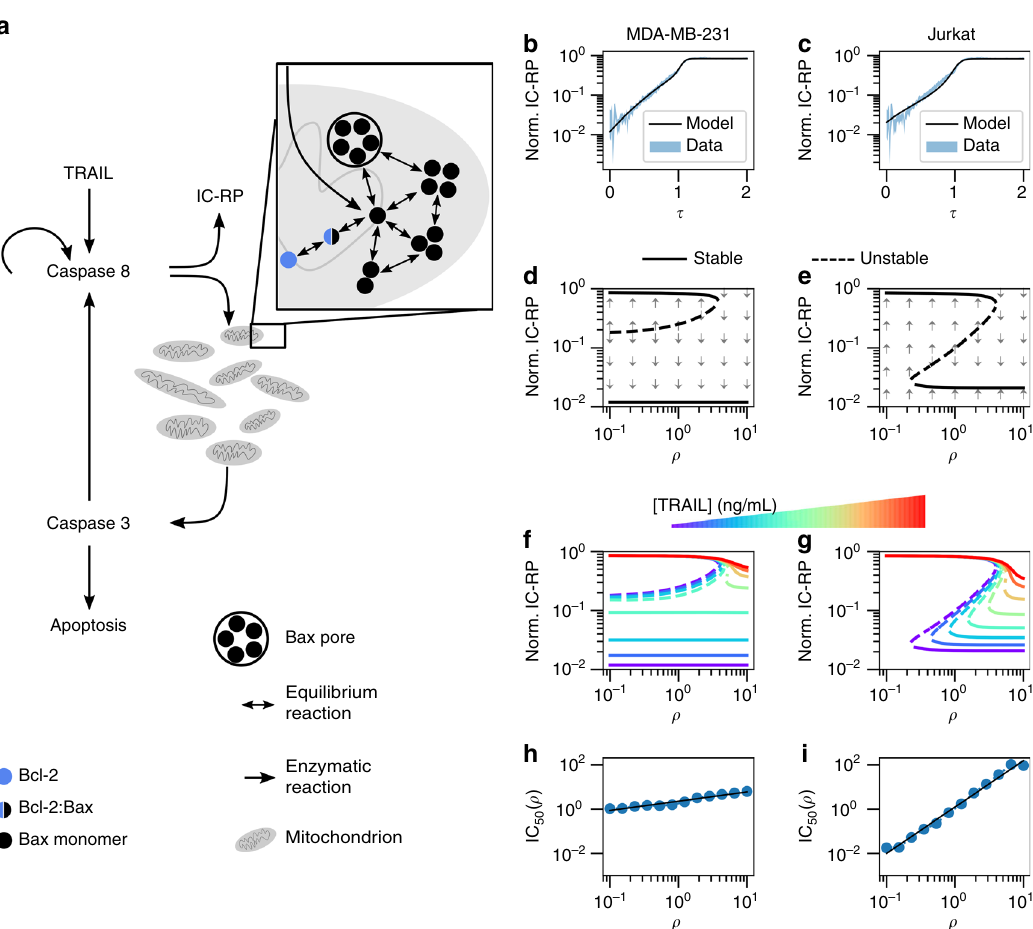
Fig. 5 Mechanism of IC 50 dependence on mitochondria density. a Simple model of apoptosis. The dynamics of initiator caspase reporter protein (IC-RP) from ref. 24 and the model-inferred dynamics corresponding to b MDA-MB-231 and c Jurkat cell lines. The model bifurcation diagrams for [TRAIL] = 0 ng/ mL in d MDA-MB-231 and e Jurkat cells. The in fl uence of TRAIL dose on the model fi xed points for f MDA-MB-231 and g Jurkat cells. The dependence of single-cell sensitivities to TRAIL on ρ for h MDA-MB-231 and i Jurkat cells. The IC 50 was estimated from Hill function fi ts of simulated data (blue circles), which were then fi t to a power law (black line). Simulations consisted of 100 cells per 20 doses of TRAIL and 12 densities of mitochondria mitochondrial outer membrane permeabilization (MOMP), and (iii) the strong positive feedback from EC to IC (see Supple-